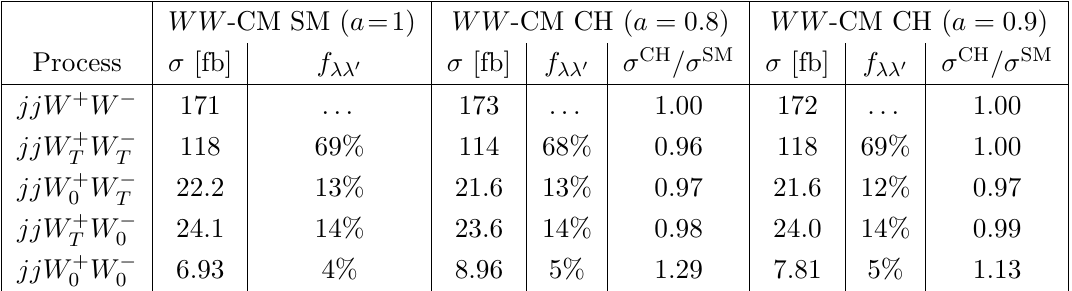
Table 2. Same as table 1 but for the WW c.m. frame ( WW